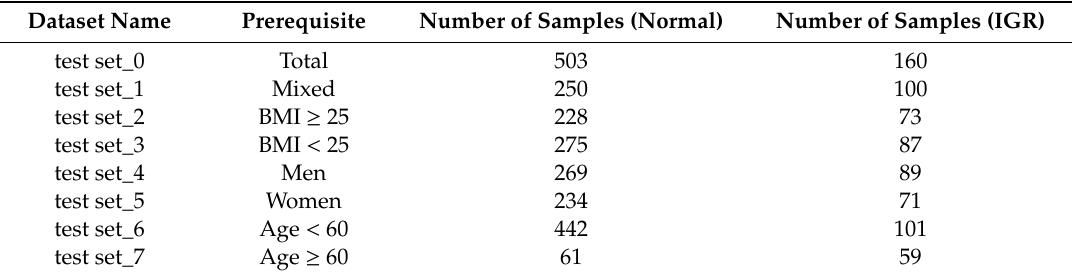
Table 2. The composition of the independent test